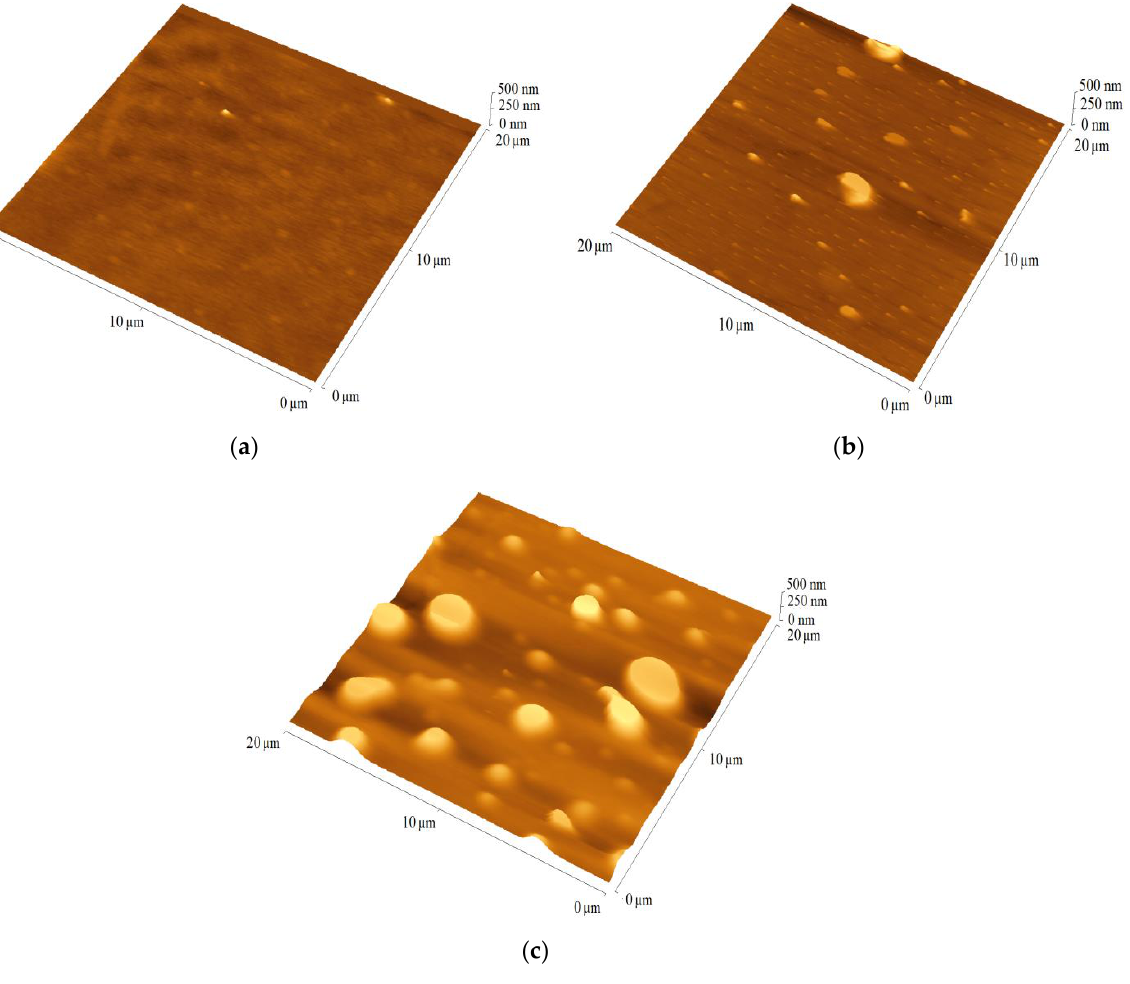
Figure 6. The AFM images of blends ( a ) P3HT:PCBM, ( b ) TPA-DT :PCBM and ( c ) TPA-DT :P3HT:PCBM.